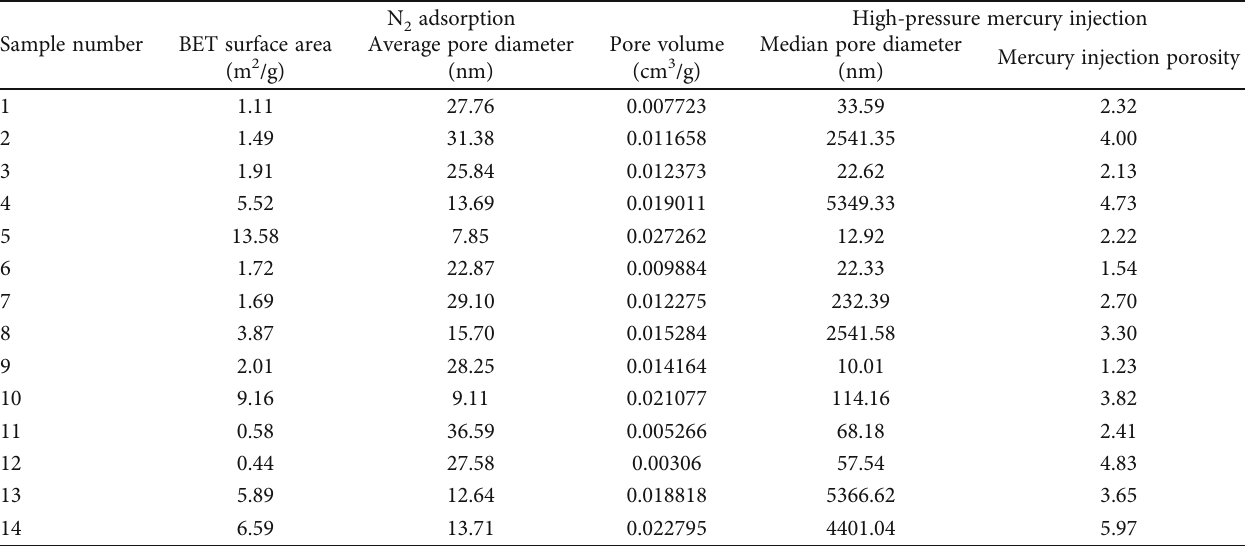
Table 3: N adsorption and high-pressure mercury injection results of shale samples for the K 2